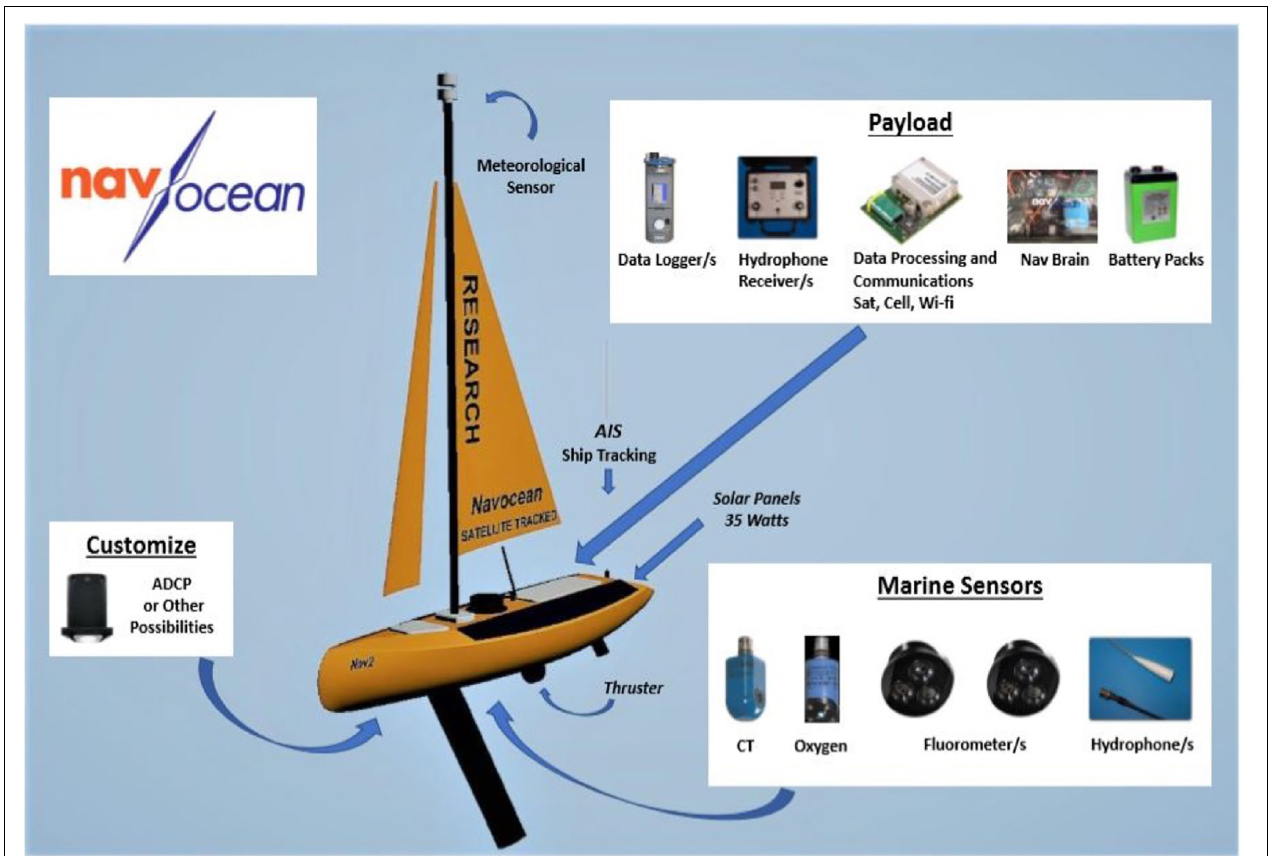
FIGURE 1 | Diagram of the Navocean Nav2 Autonomous Sail Vehicle and